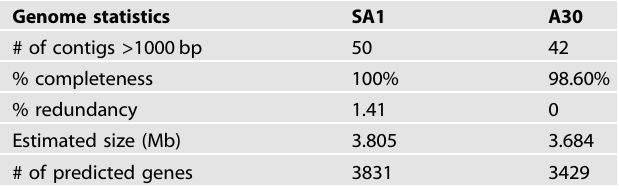
Table 1. Genome statistics for draft genomes of Sul fi tobacter sp. SA1 and Olleya sp.